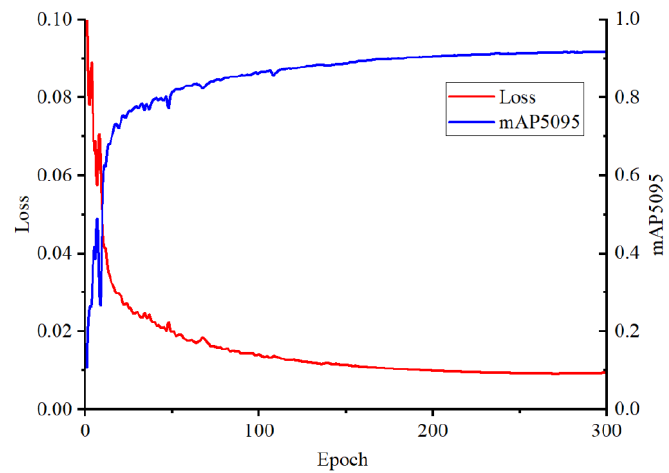
Figure 21. Loss and mAP5095 during the training process of the YOLOv5 model in the line field experiments.